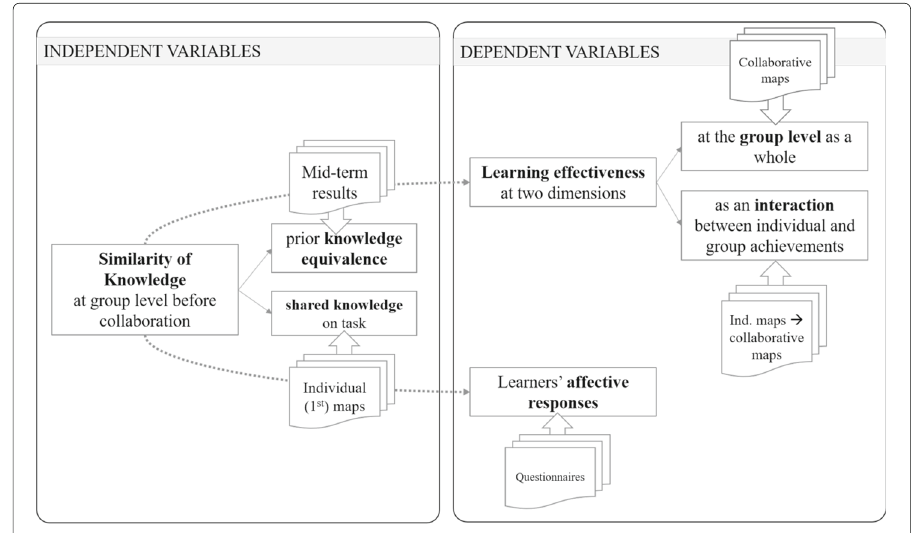
Fig. 2 Variables involved in this